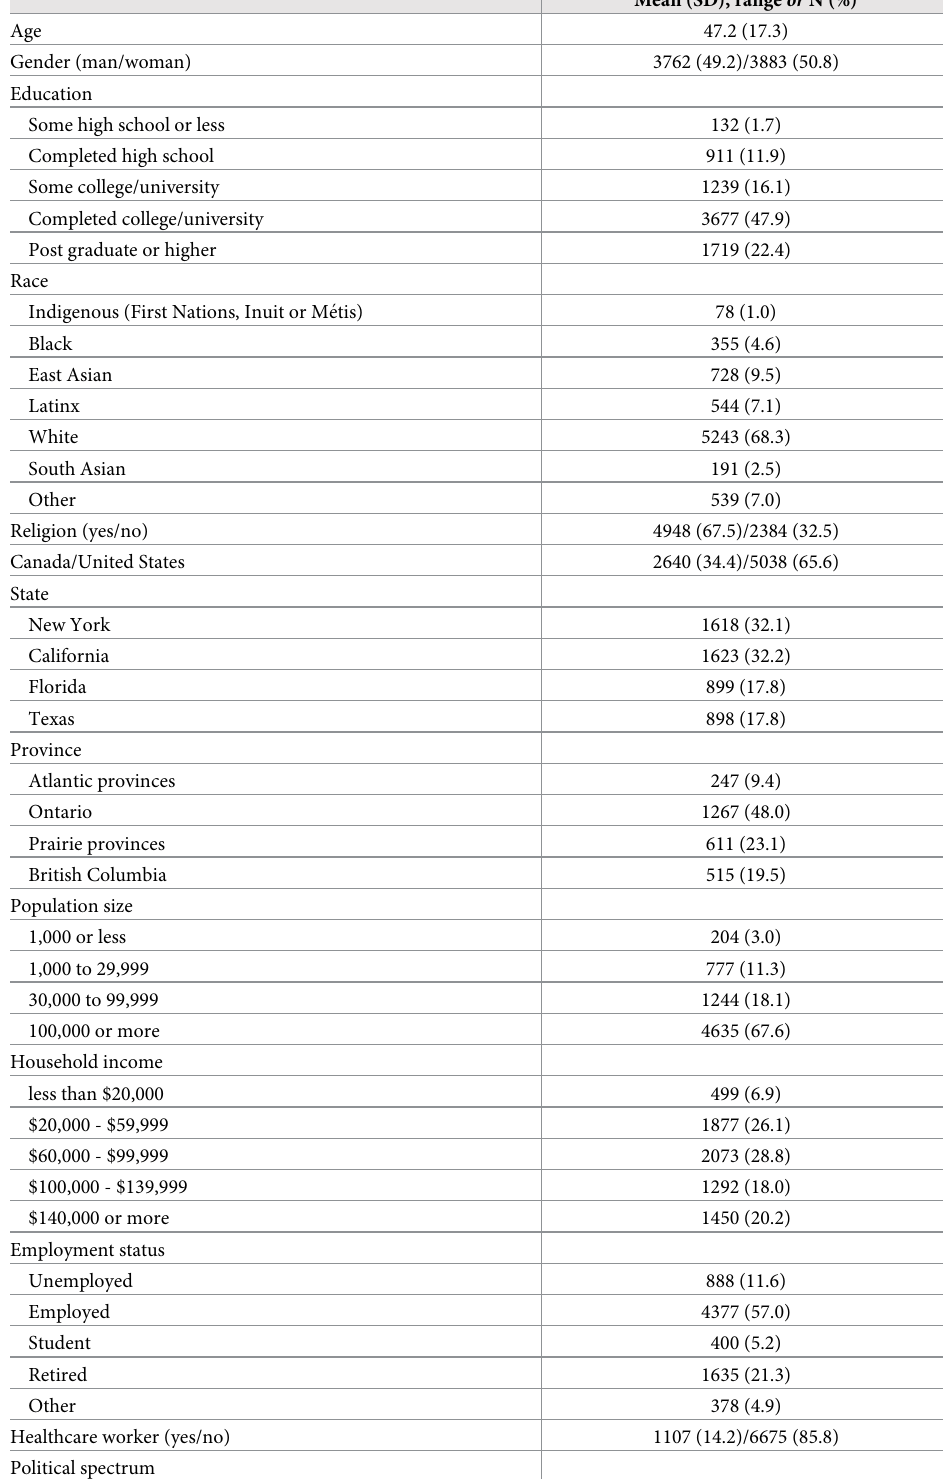
Table 1. Participant characteristics (N =